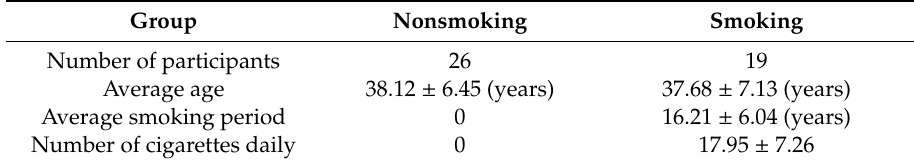
Table 2. Participants in the nonsmoking and smoking groups.